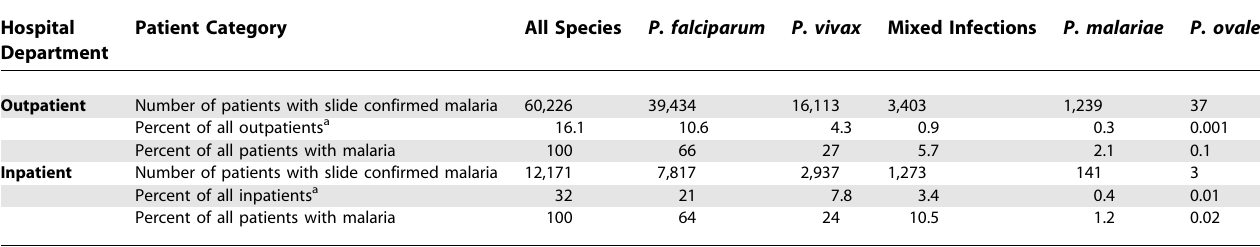
Table 1. Number of Symptomatic Patients with Laboratory-Confirmed Malaria at RSMM Hospital (2004–2007)